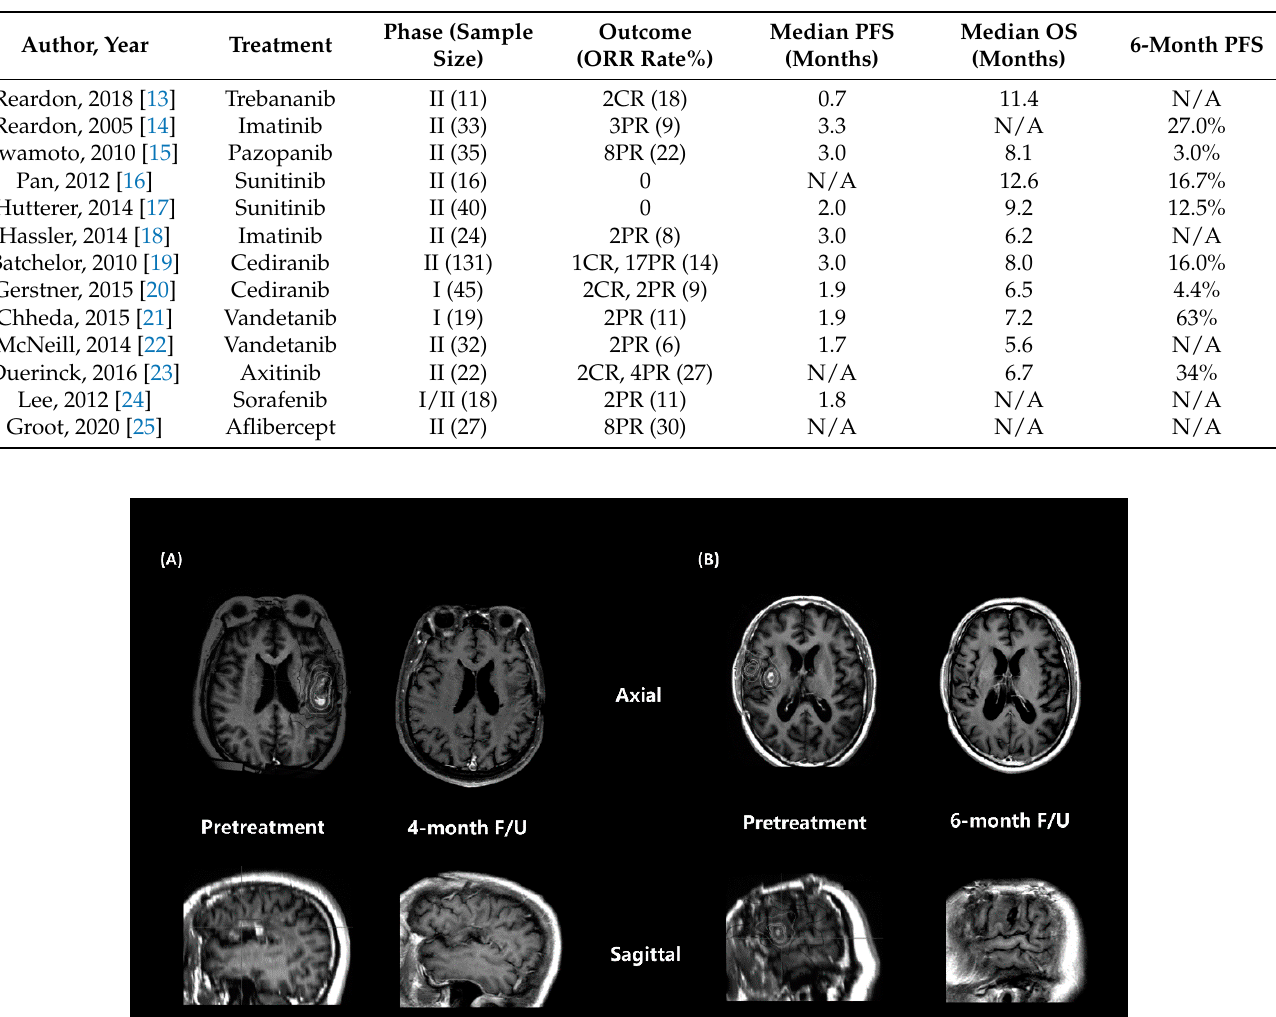
Table 3. Reported anti-angiogenic treatment for recurrent glioblastoma.